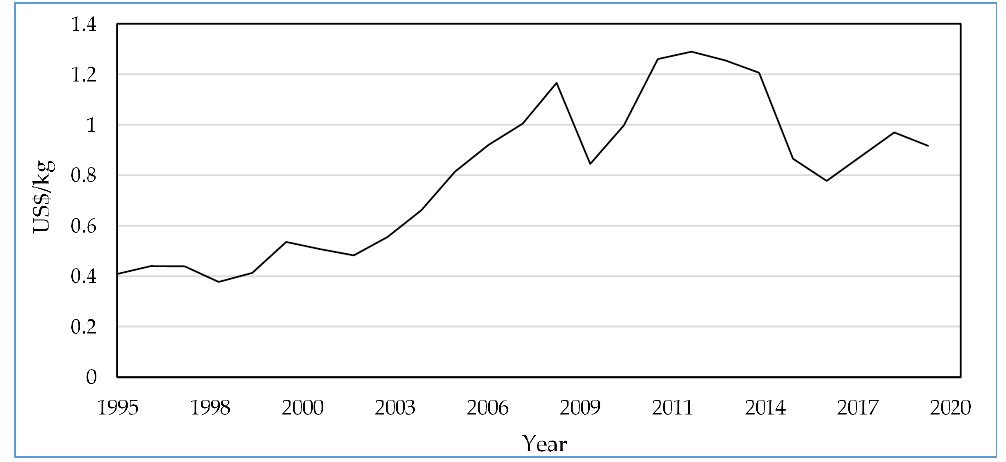
Figure 3. Historical gasoline prices [72] . Table 5. Outcome of the economic assessment.